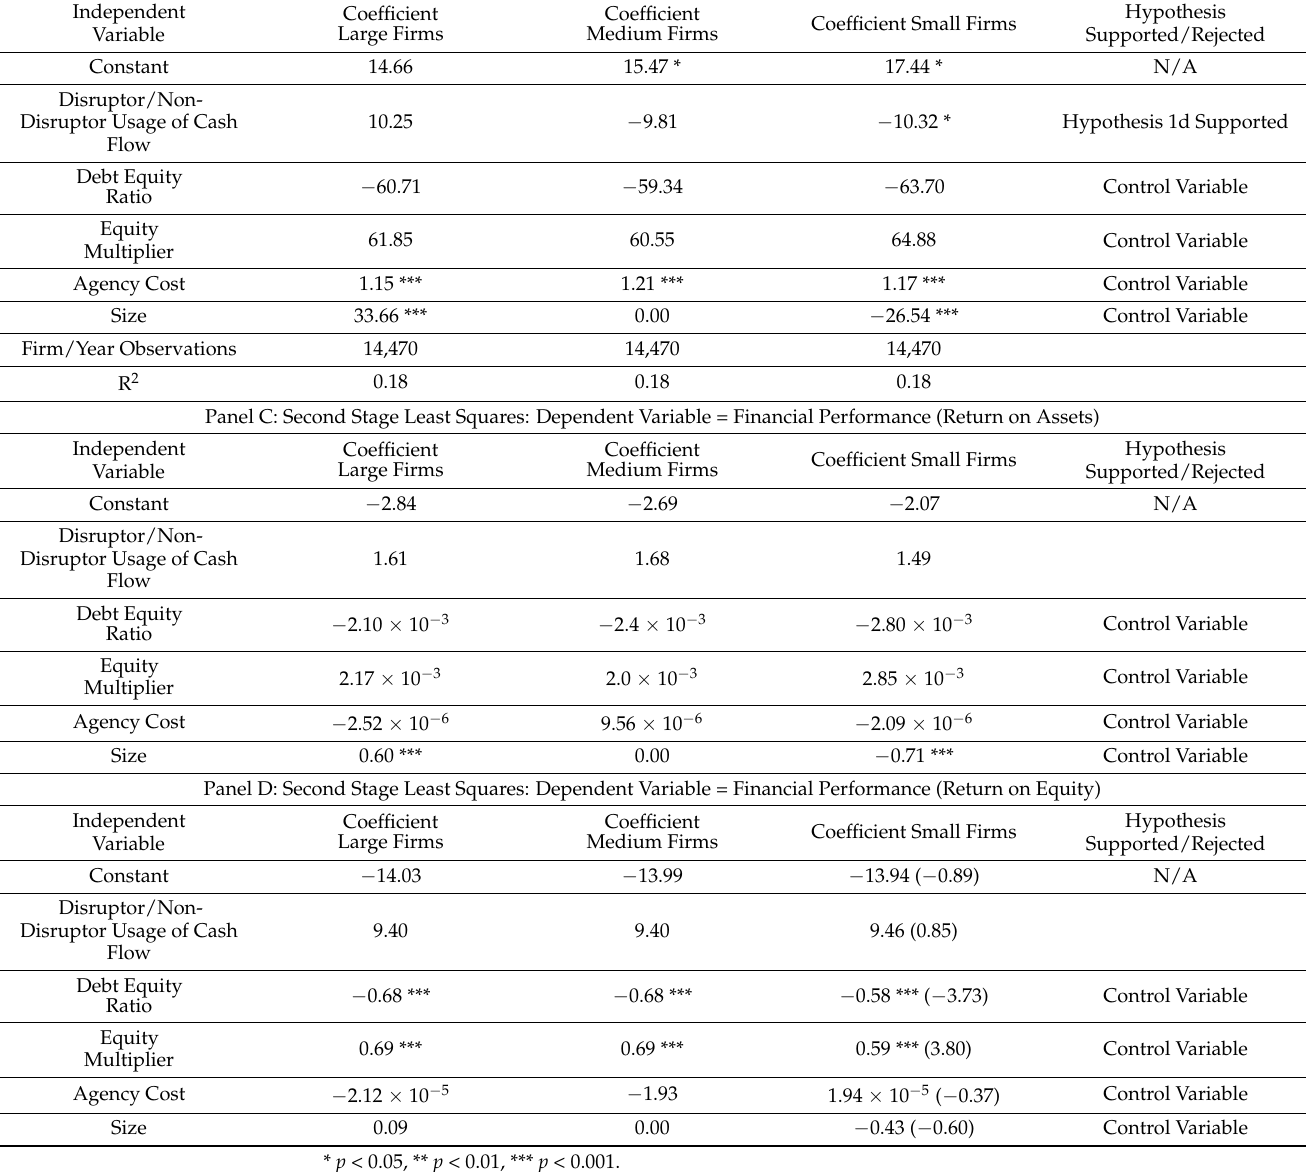
Table 7. Cont . Panel B: Second Stage Least Squares: Dependent Variable = Financial Performance (Security Returns)